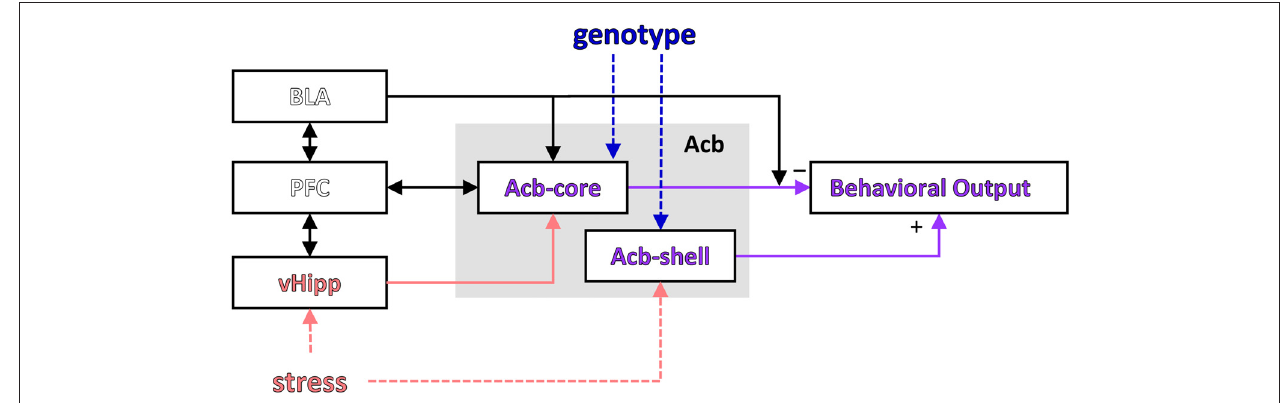
FIGURE 3 | Modulation of a putative LI circuit by stress or the GDNF genotype. A putative circuit for LI (modified after Schmajuk et al., 1997; Weiner, 2003) indicating the brain regions where activity was affected by stress and/or genotype. PFC, prefrontal cortex; vHipp, ventral hippocampus; Acb, nucleus accumbens; Acb-core, nucleus accumbens core; Acb-shell, nucleus accumbens